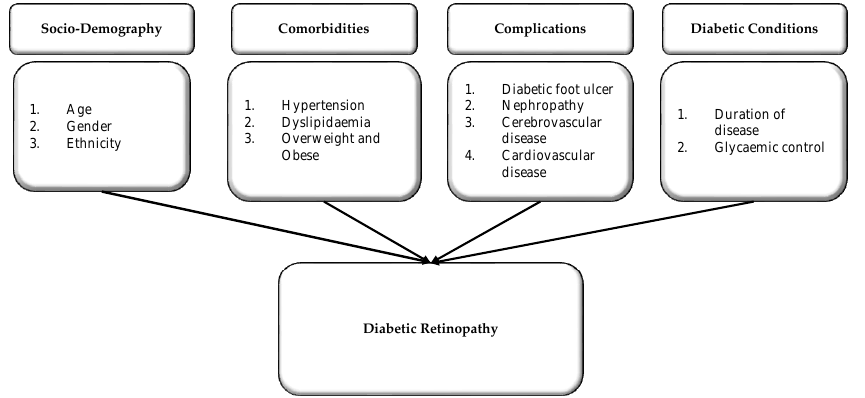
Figure 1. Suggested conceptual framework.